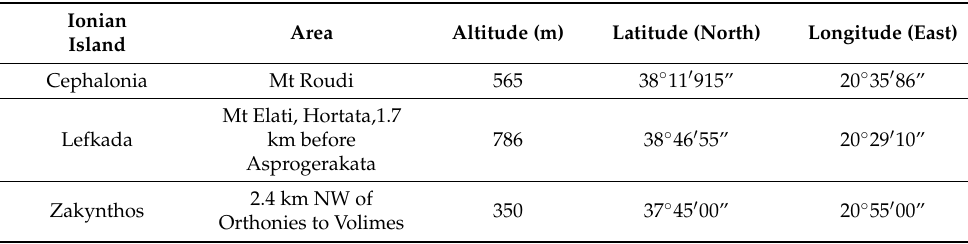
Table 3. Localities collection of Thymus holosericeus from three Ionian Islands (Greece) recorded in the WGS84 coordinate